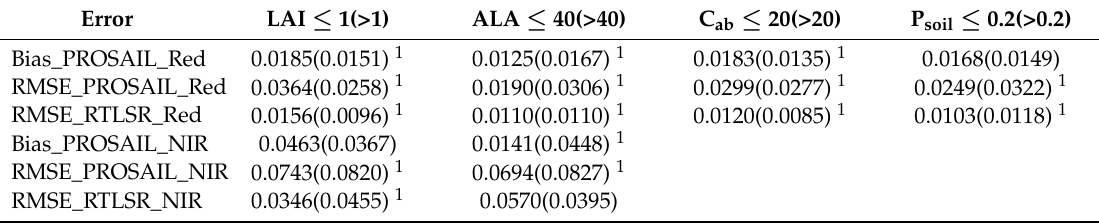
Figure 7. Comparison of the directional reflectances between the PROSAIL simulation and RTLSR inversion in the red and NIR bands for 21 sets of observations, where the two gray dashed lines show the 0.02 and 0.05 tolerances: ( a , b ) comparison of the directional reflectances between the PROSAIL simulation and observations at five equal density levels from 1 (maximum) to 5 (minimum). ( c , d ) Comparison for RTLSR retrievals and observations. ( e – g ) Relationships between bias and three parameters, which are AFX, LAI and ALA, respectively. Table 5. The statistics of the average error between the PROSAIL simulations/RTLSR inversions and observations for the four typical parameters in Figure 5, where the bias refers to the mean of their absolute values.